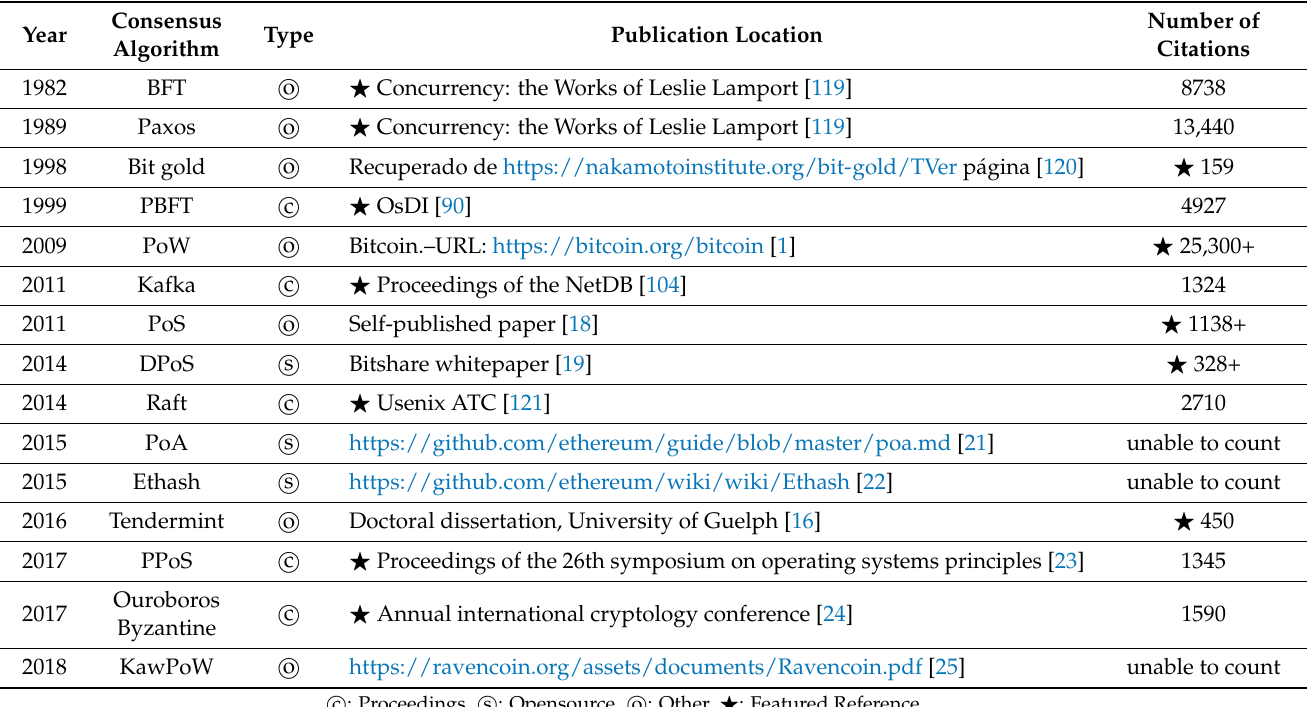
Table 5. Well-known consensus